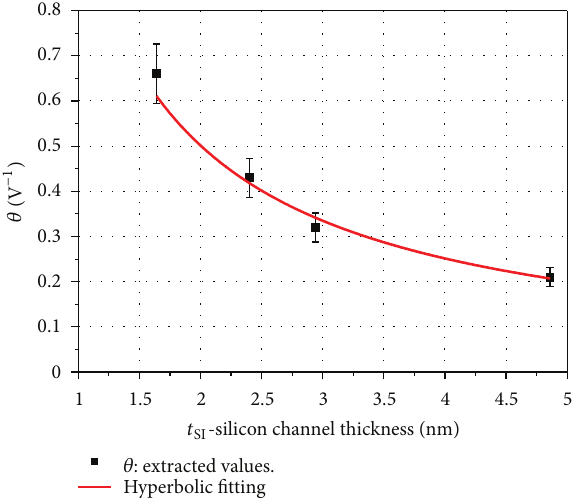
Figure 5: Extracted transconductance 𝑔 𝑚 and effective mobility 𝜇 versus 𝑉 for four NSB devices (dices E15, C12, G15, and eff DS ) of 1.6, 2.4, 2.9, and 4.9 nm, C03) having a channel thickness ( 𝑡 SI respectively. 𝑔 𝑚 is extracted from Figure 4 as the slope of the 𝐼 𝑉 for positive 𝑉 . GS GS